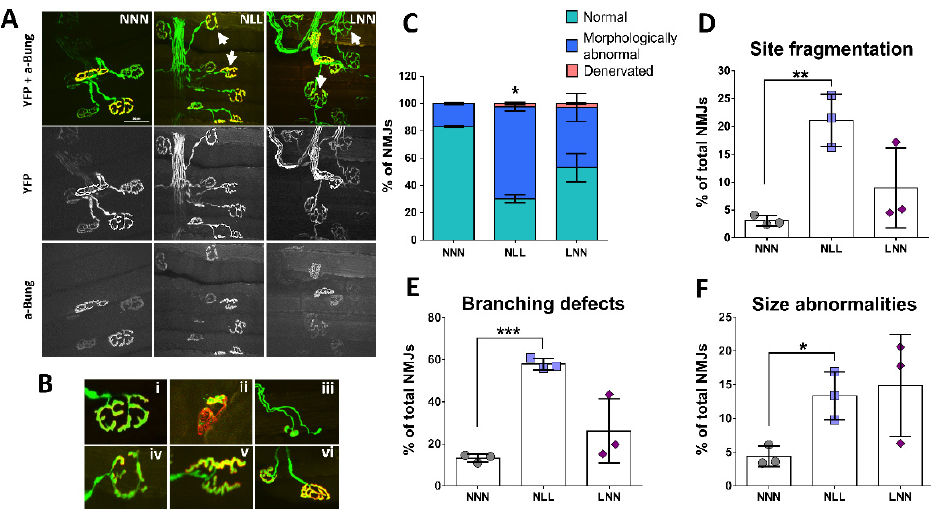
Figure 3. Fluorescent images of NMJ sites in EDL muscle of 12-week-old mice. The pre-synaptic terminal expressing YFP (green) and the post-synaptic end plate stained with α -bungarotoxin (red) are in full alignment. Representative images of NMJ sites in mice of NLL and LNN groups show morphological aberrations (arrow), in comparison with the “pretzel” shape seen in the control group ( A ). Example images of: ( B ) Normal “pretzel shape” NMJ site (i), partially denervated NMJ site, where AChR site is vacated (ii), NMJ with no perforation (iii), limited NMJ branching (iv), fragmented NMJ site with no “pretzel-like” shape (v) and small size of NMJ site (vi). Classification of structural changes of the NMJ site in EDL muscle of 12-week-old mice showed a high proportion of morphological abnormalities ( C ) such as increased site fragmentation ( D ), with limited/defective branching ( E ) or with small size of the synaptic area ( F ) only in the NLL group as compared to NNN. * p ≤ 0.05, ** p ≤ 0.01, and *** p ≤ 0.001 (mean ± SD; n = 3 animals in each group, minimum 80 and maximum 250 NMJs were assessed per each muscle. Scale bar: 50 μ m; magnification: 60×. Individual NMJs where scored into normal (N), morphologically abnormal (MA) and denervated (D) in mice of all three groups. Analysis of NMJs showed a significantly higher percentage of morphologically abnormal NMJs in mice of the NLL group, compared with those of the NNN (control) and LNN groups. The percentage of NMJs showing partial or full denervation was limited in mice from both NLL and LNN groups (Figure 3C). NMJs